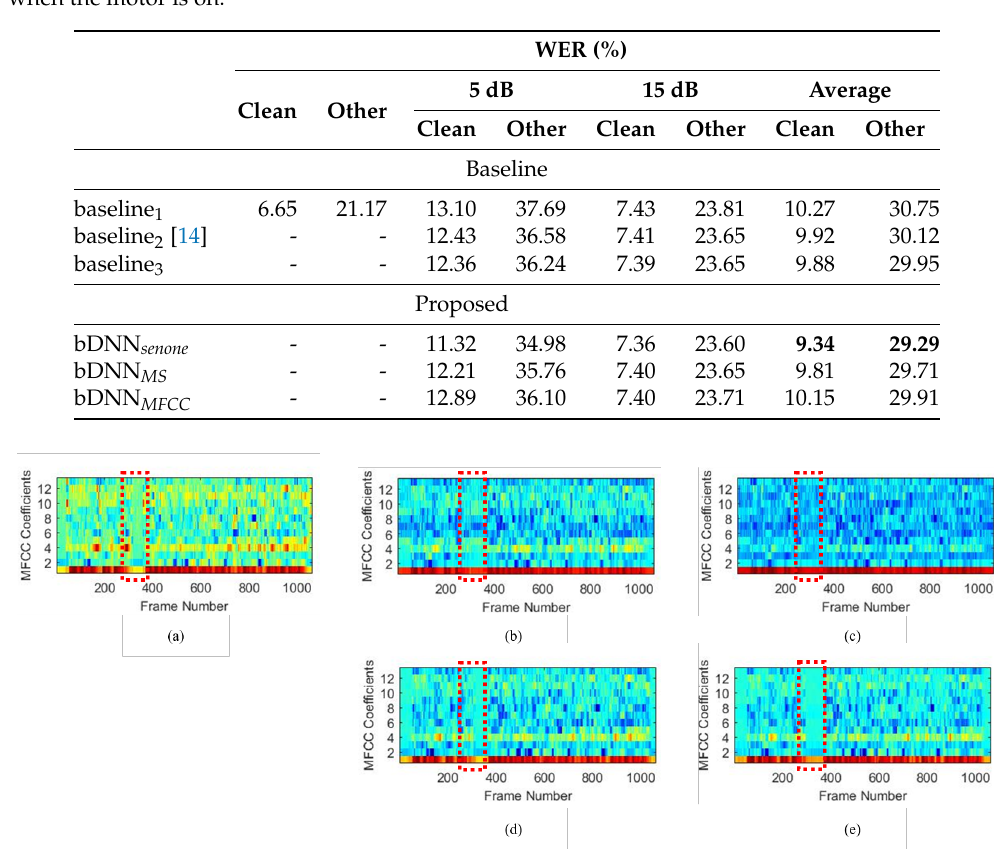
Figure 5. An example of the spectral feature mapping ( a ) clean MFCC feature; ( b ) noisy MFCC feature (SNR 5 dB, “motor off” state) ( c ) noisy MFCC feature (SNR 5 dB, “motor on” state); ( d ) reconstructed MFCC feature (SNR 5 dB, “motor off” state), ( e ) reconstructed MFCC feature (SNR 5 dB, “motor